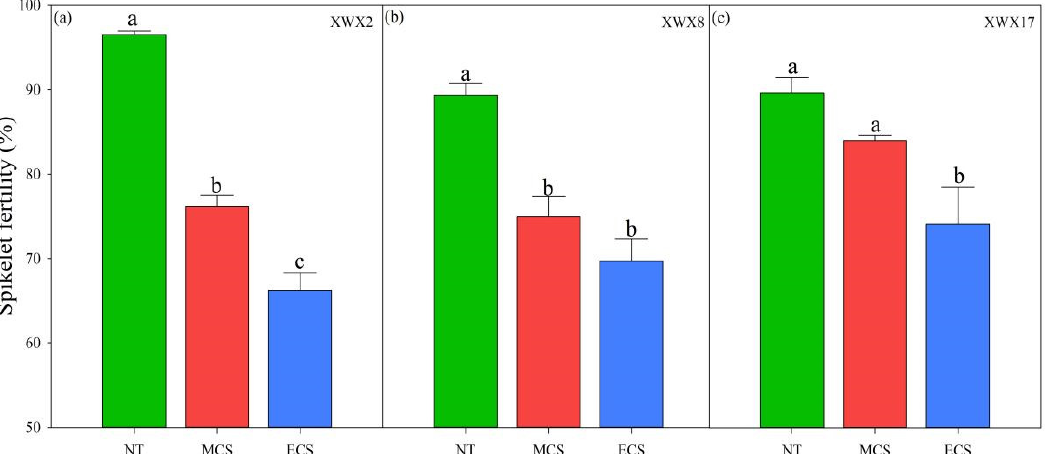
Figure 1. The spikelet fertility of three inbred late varieties under different temperature treatments. ( a ) XWX2. ( b ) XWX8. ( c ) XWX17. XWX2: Xiangwanxian2; XWX8: Xiangwanxian8; XWX17: Xiangwanxian17; NT: Normal temperature control; MCS: Moderate chilling stress; ECS: Extreme chilling stress. Different lowercase letters denote statistical differences among treatments of a cultivar at the 5% level according to LSD test. Error bars above mean indicate standard error ( n = 3).